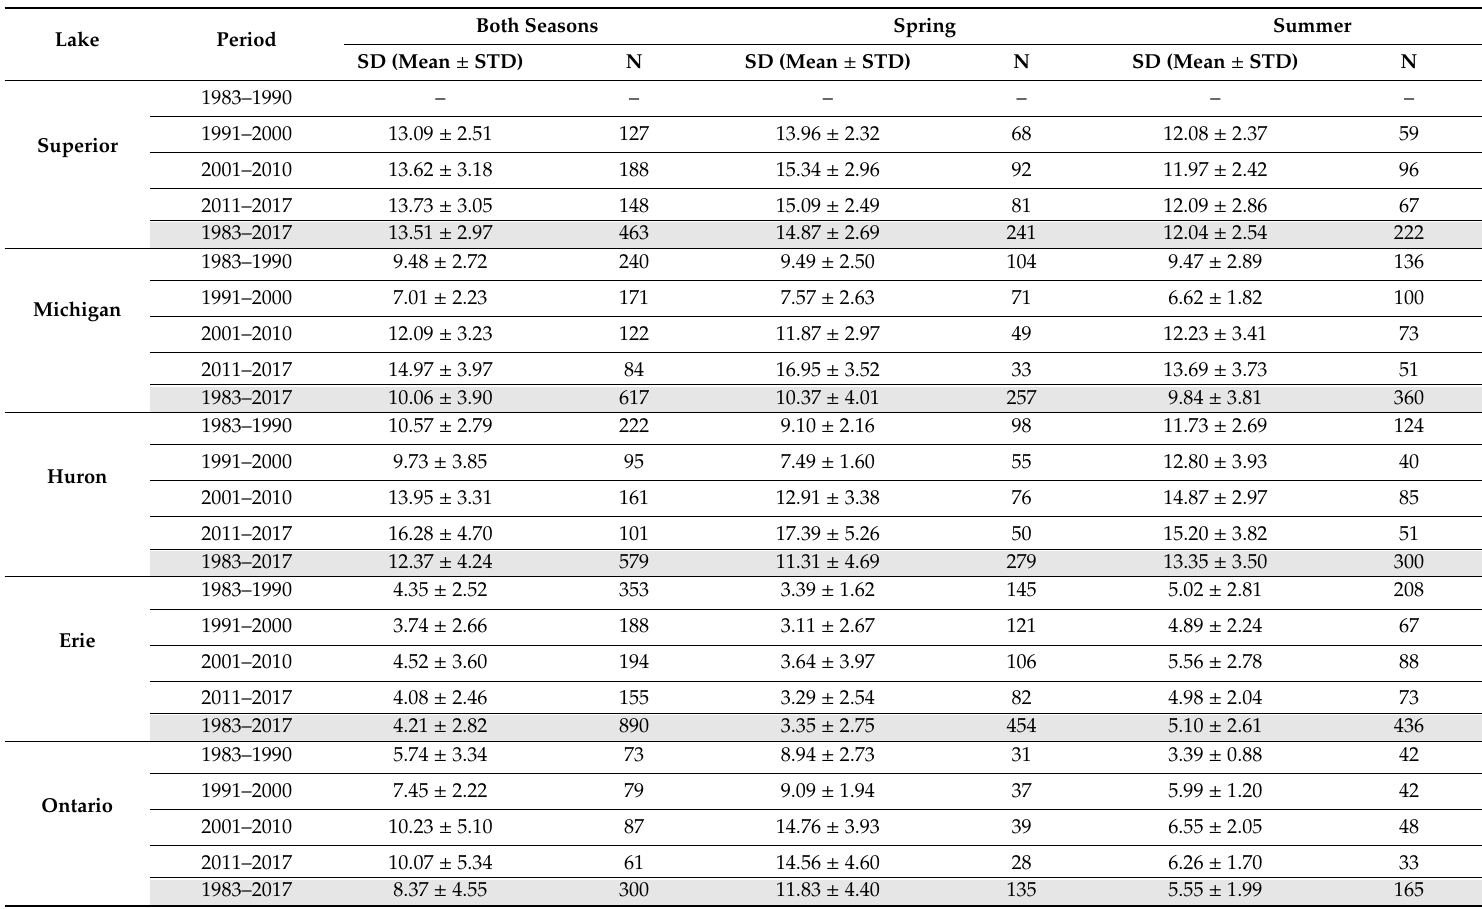
Table 1. Statistics of in-situ water SD in the Great Lakes [mean, standard deviation (STD), and number of data (N)] for the di ff erent time periods, i.e.,